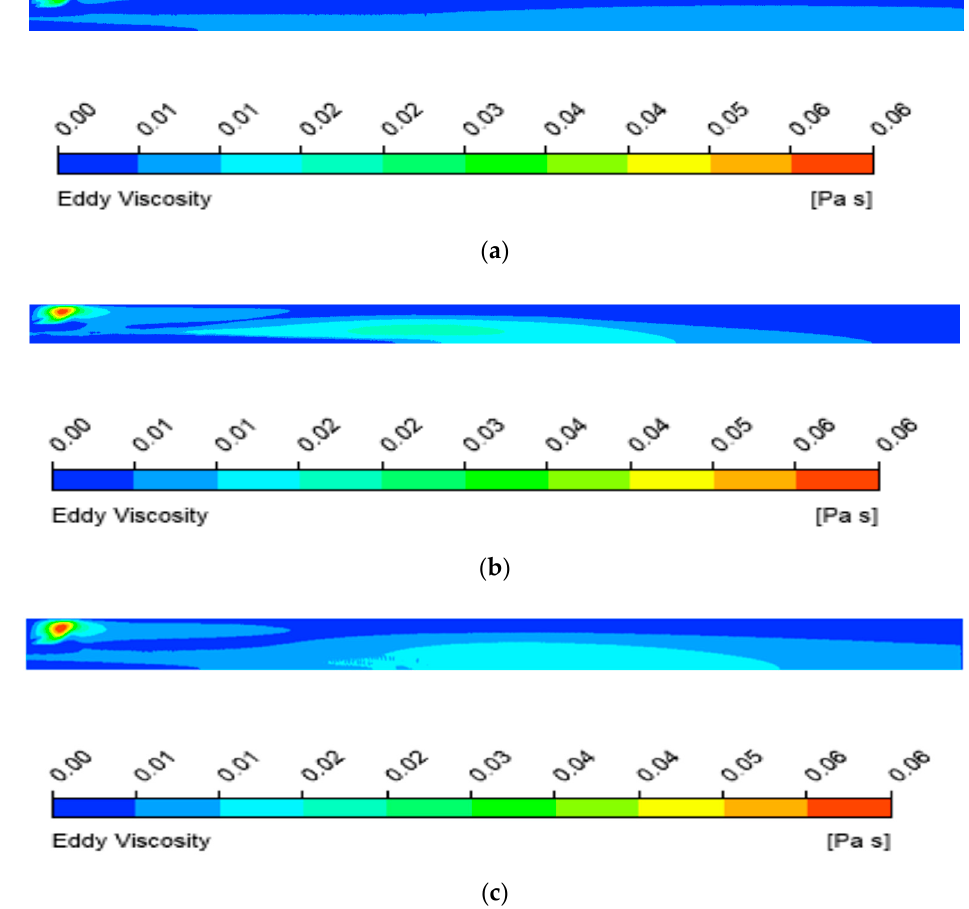
Figure 10. ( a ) Eddy viscosity field given by the default GEKO model; ( b ) Eddy viscosity field given by the standard k-epsilon model; ( c ) Eddy viscosity field given by the GEKO model with Csep = 1.